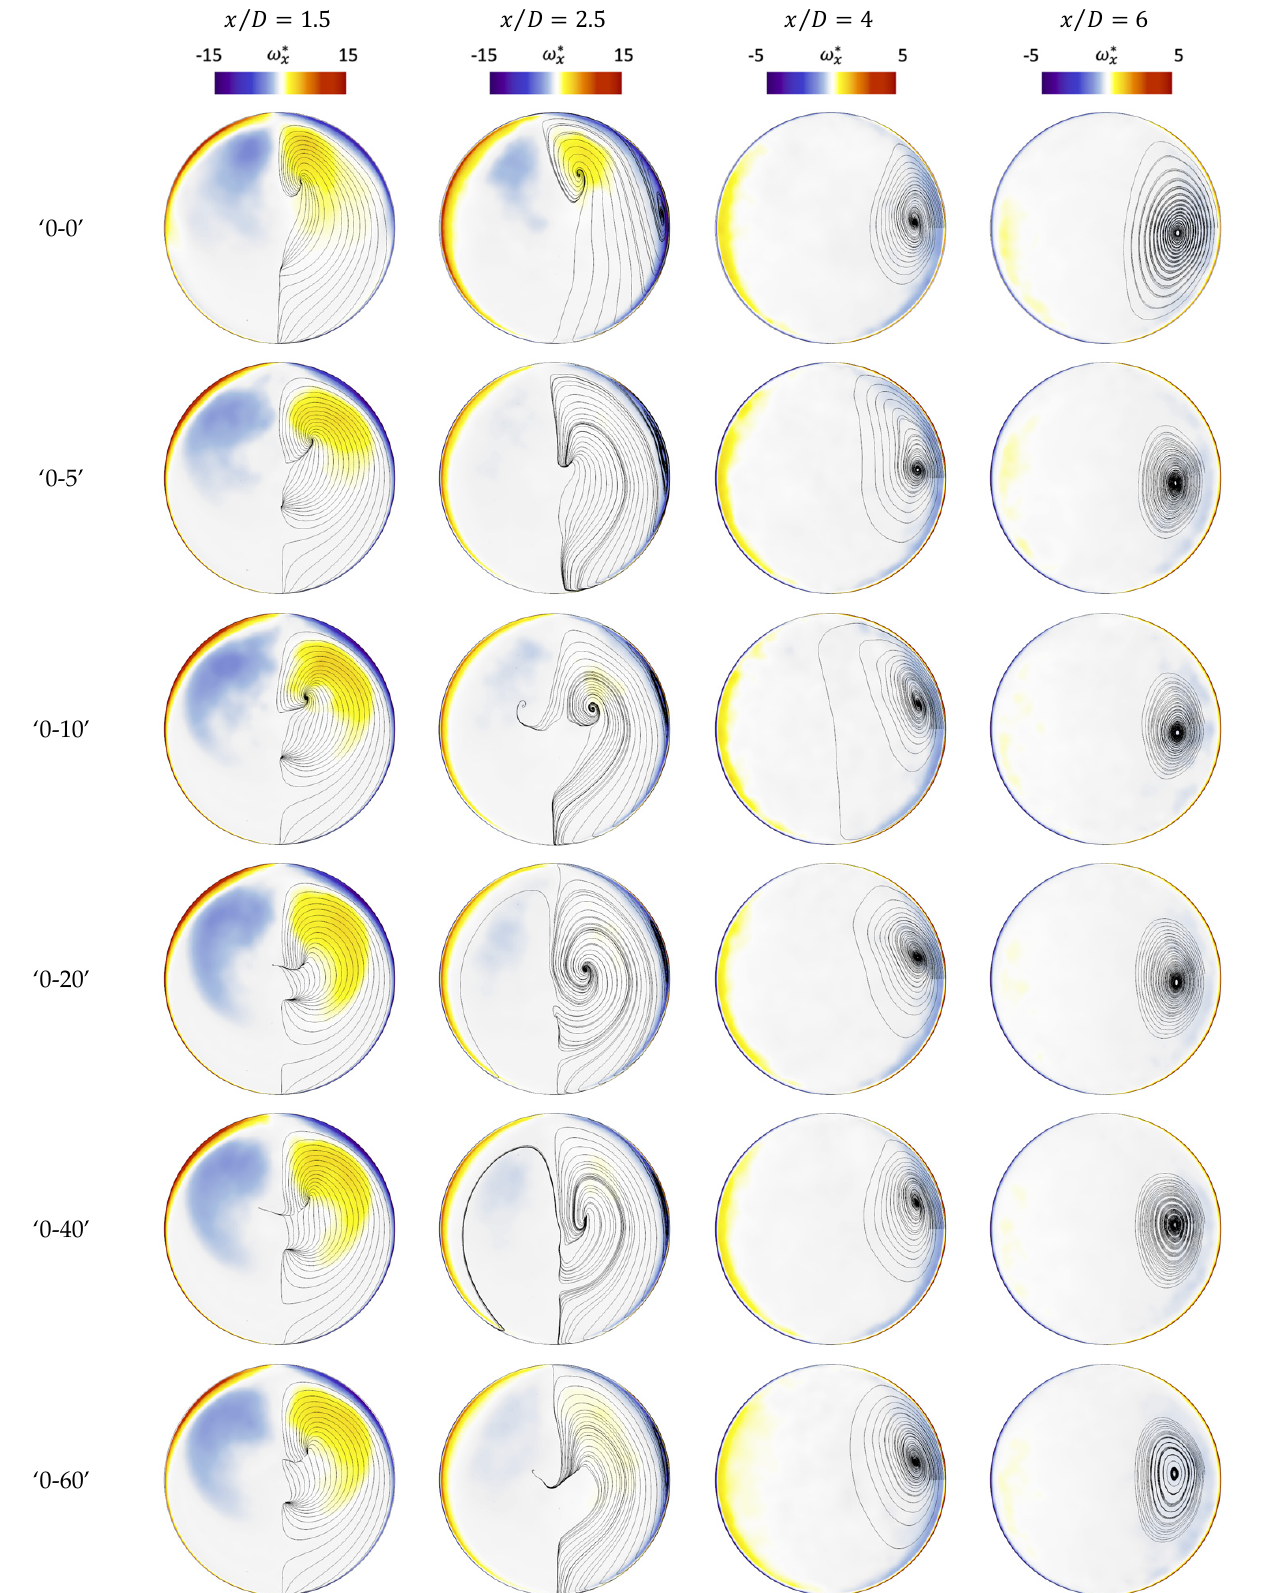
Figure 16. Contour plots of ω ∗ x with in-plane mean velocity streamlines (black lines) on different cross-sections for cases with uniformly distributed BCs—Reattachment region.